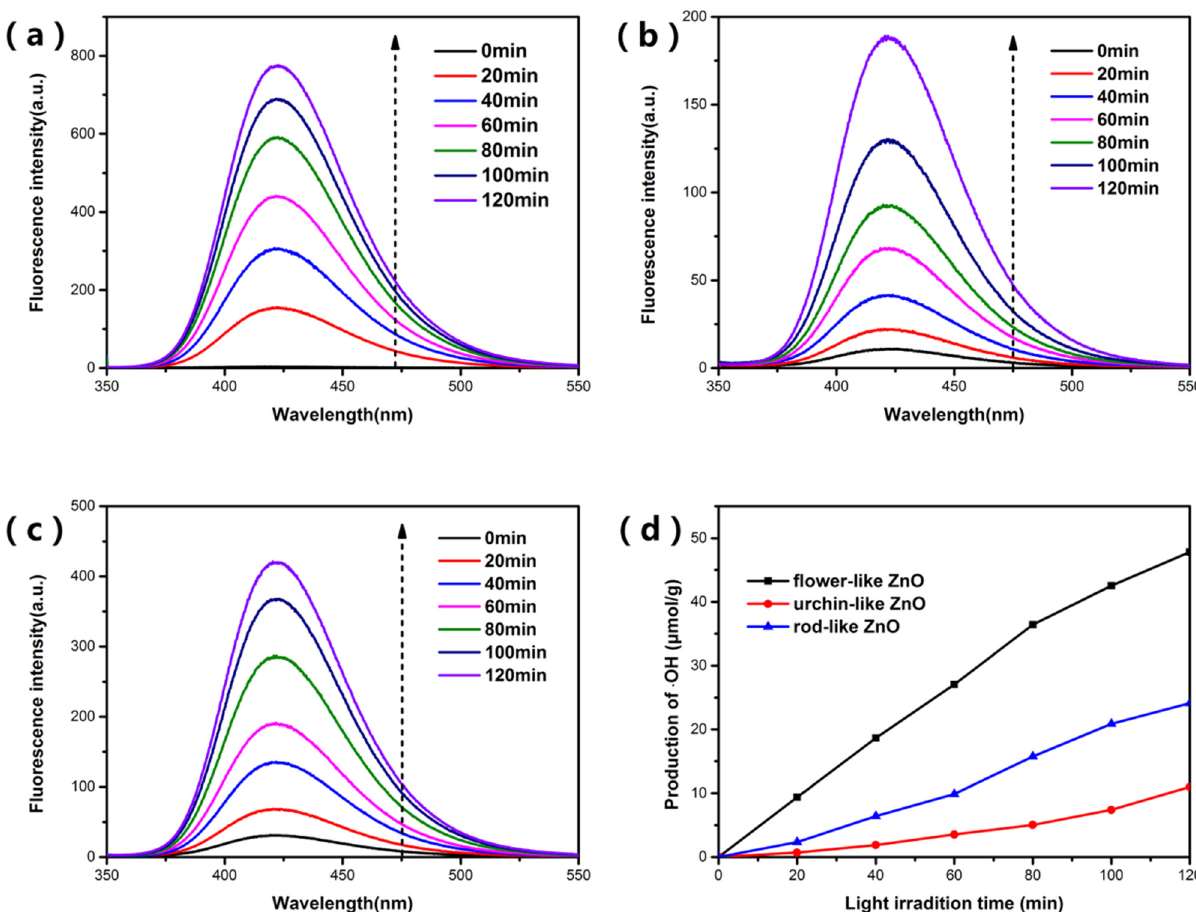
Figure 11: Fluorescence spectra of the amount of 2 - OH - TA produced by the samples under simulated sunlight over time: ( a – c ) are the spectra of fl ower - like ZnO, urchin - like ZnO, and rod - like ZnO, respectively, ( d ) is the yield of ˙ OH in ZnO suspension under simulated sunlight with time.